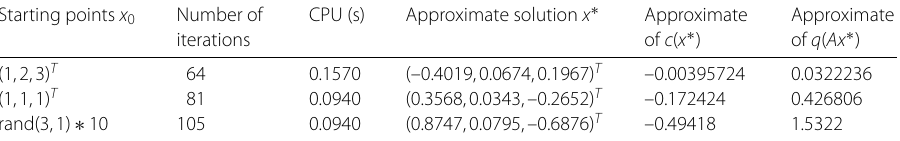
Table 3 Results for Example 5.4 using Qu and Xiu method in [6]